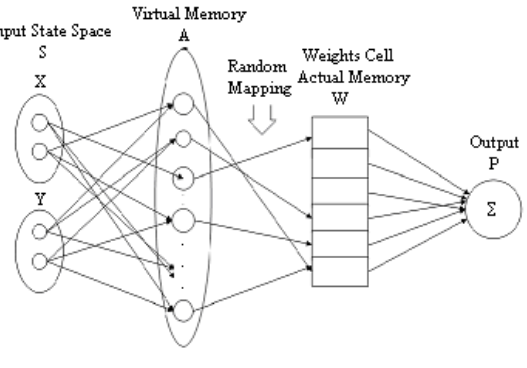
Figure 1. A block diagram of a CMAC.